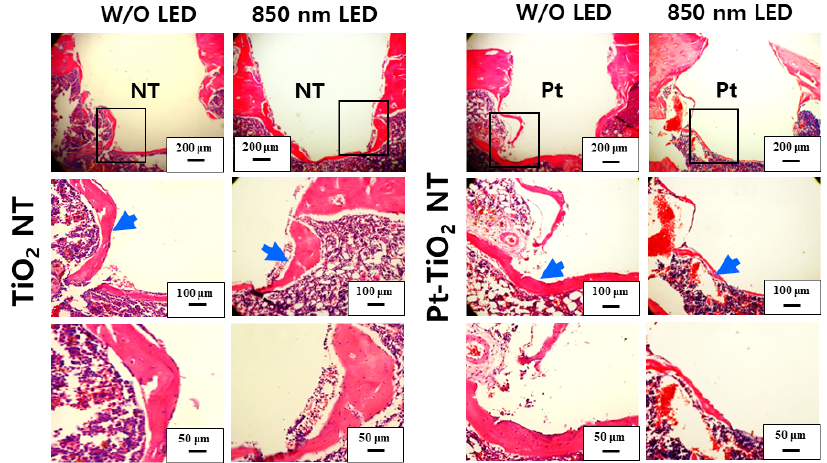
Figure 11. H&E-stained images of the tissues around the TiO 2 NT- and Pt-TiO 2 NT-treated implants after six weeks.